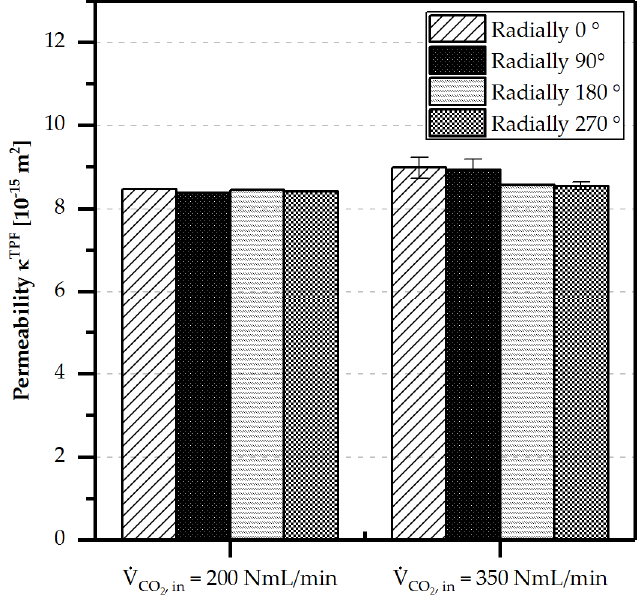
. V l,feed,in = 5 mL/min, ϑ inlet = 40 ◦ C,